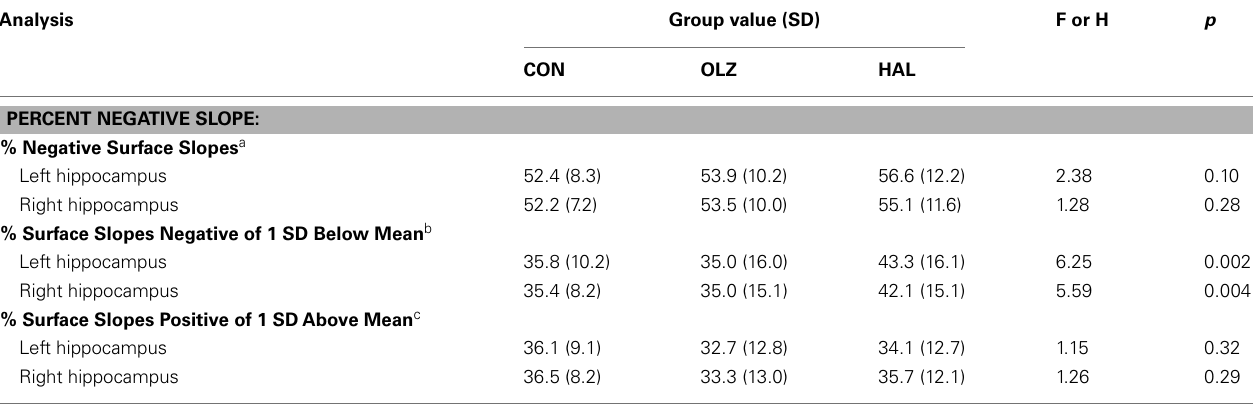
Table 2 | Statistical analysis of surface point slopes across groups.